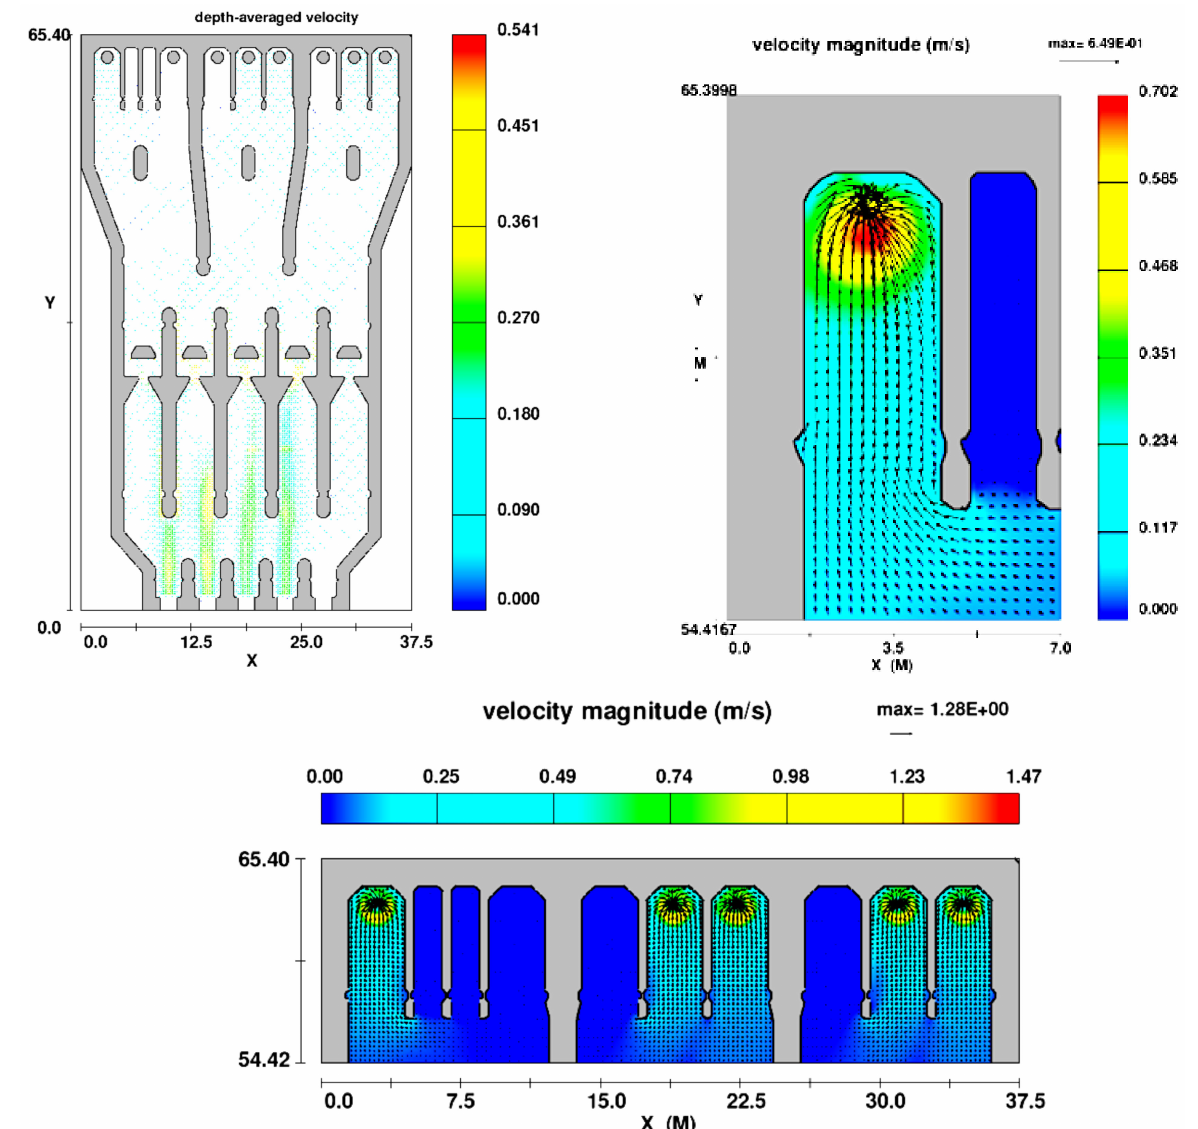
Figure 6. Field vector of the velocity at the basin for scenario I—3D